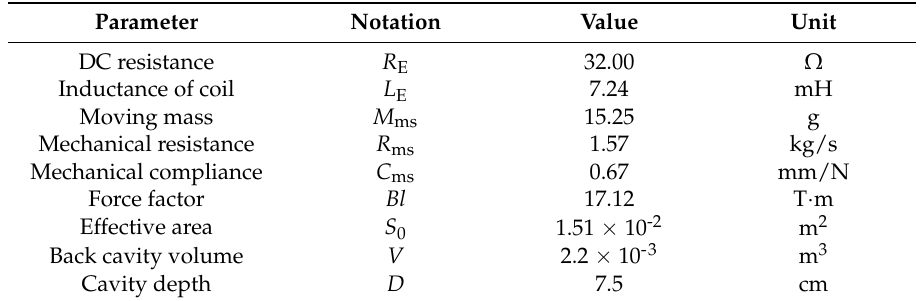
Table 1. Measured Thiele–Small (TS) parameters and dimensions of a closed-box loudspeaker unit.